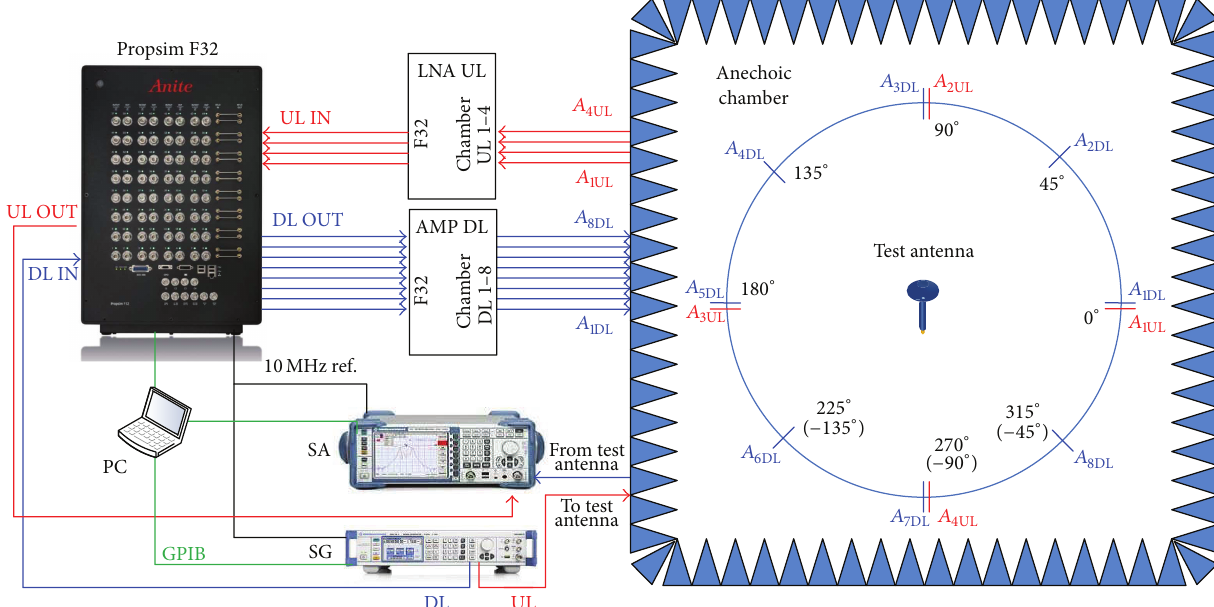
Figure 11: An illustration of the measurement system. Blue indicates the downlink and red denotes the uplink. Note that low noise amplifiers (LNAs) were used in the uplink, because the signals received by probes may have low signal to noise ratio (SNR). In the downlink, the amplification is typically done for signals with good SNRs. Different local oscillators are used in the RF channels serving uplink and downlink, especially in FDD case. All local oscillators in a fading emulator (or a set of fading emulators) typically share a common reference clock to guarantee stable synchronization. The reference clock can be taken, for example, from a satellite clock signal and distributed to different units.